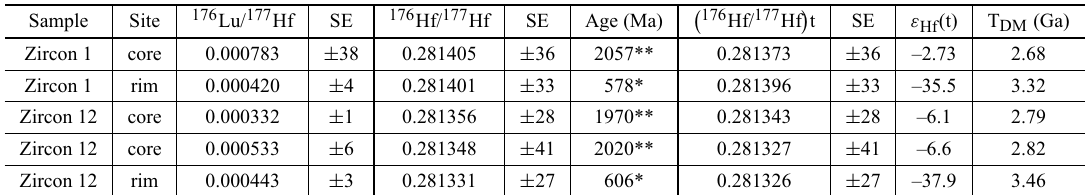
Results of in situ Lu-Hf LA-MC-ICP-MS